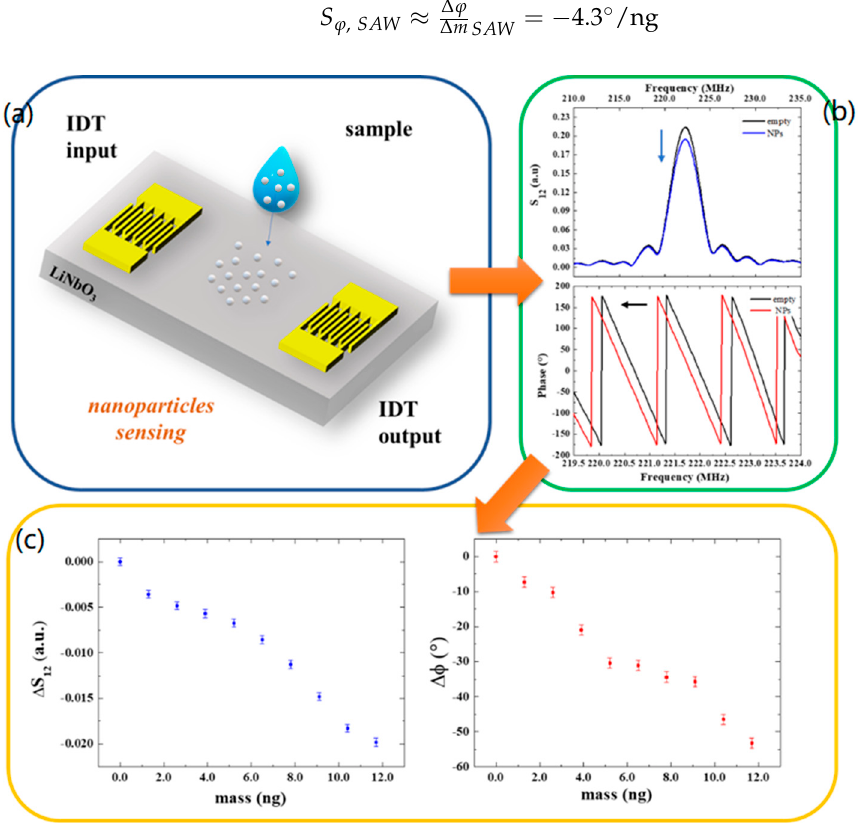
Figure 3. (a) Schematic illustration of a SAW device and nanoparticle deposition. (b) S 12 and phase spectra of the SAW device without and with nanoparticles. (c) Transmitted signal variation and spectra of the SAW device without and with nanoparticles. ( c ) Transmitted signal variation and phase phase shifts as a function of the mass of particles at the resonant frequency. shifts as a function of the mass of particles at the resonant